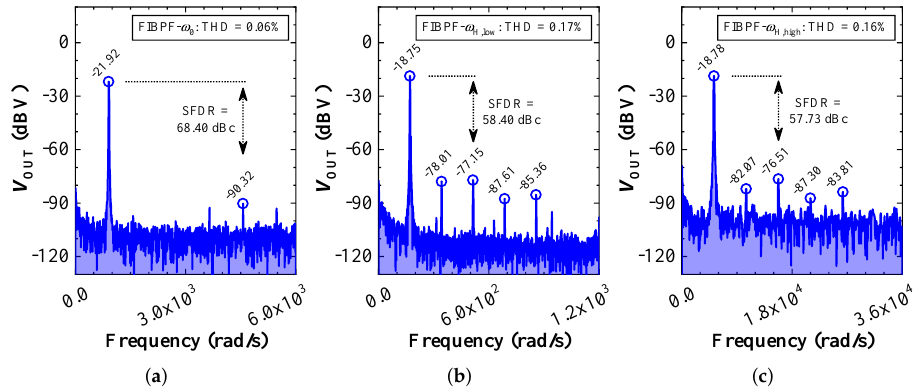
Figure 18. Experimentally obtained Fourier spectrums of the proposed FIBPF at frequency of ( a ) ω 0 = 912.44 rad/s, ( b ) ω H,low = 171.53 rad/s, and ( c ) ω H,high = 5.26